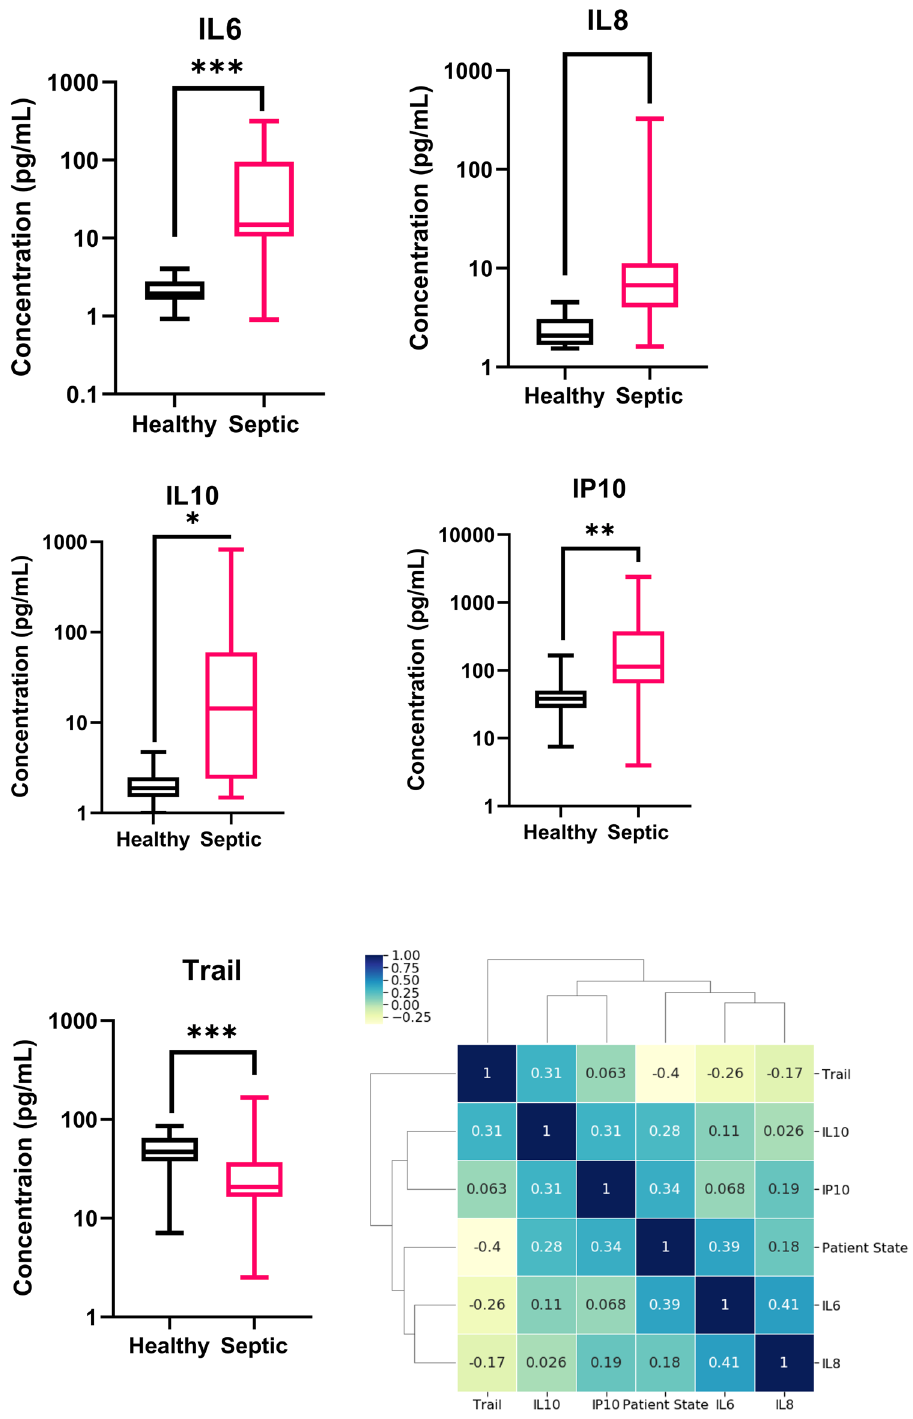
Figure 3. ( A – E ) Comparing the healthy control vs septic patient samples for IL-6, IL-8, IL-10, IP-10 and TRAIL. Significance *p < 0.1, **p < 0.01, ***P < 0.001. ( F ) Correlation matrix with heatmap and cluster map showing relation between the study biomarkers and patient